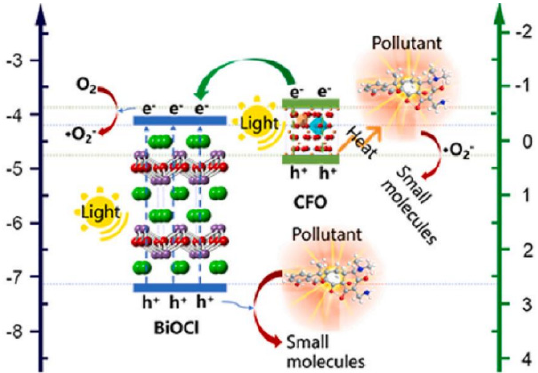
Figure 13. Schematic diagram of the photothermal catalytic mechanism of CFO-BiOCl (Reprinted/adapted with permission from Ref. [115]. Copyright 2021, copyright Elsevier).